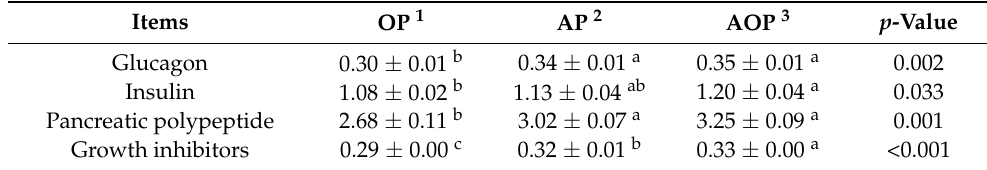
Table 5. Effect of different forage source diets on pancreatic hormone levels in preweaning yak calves (unit: µ g/L).